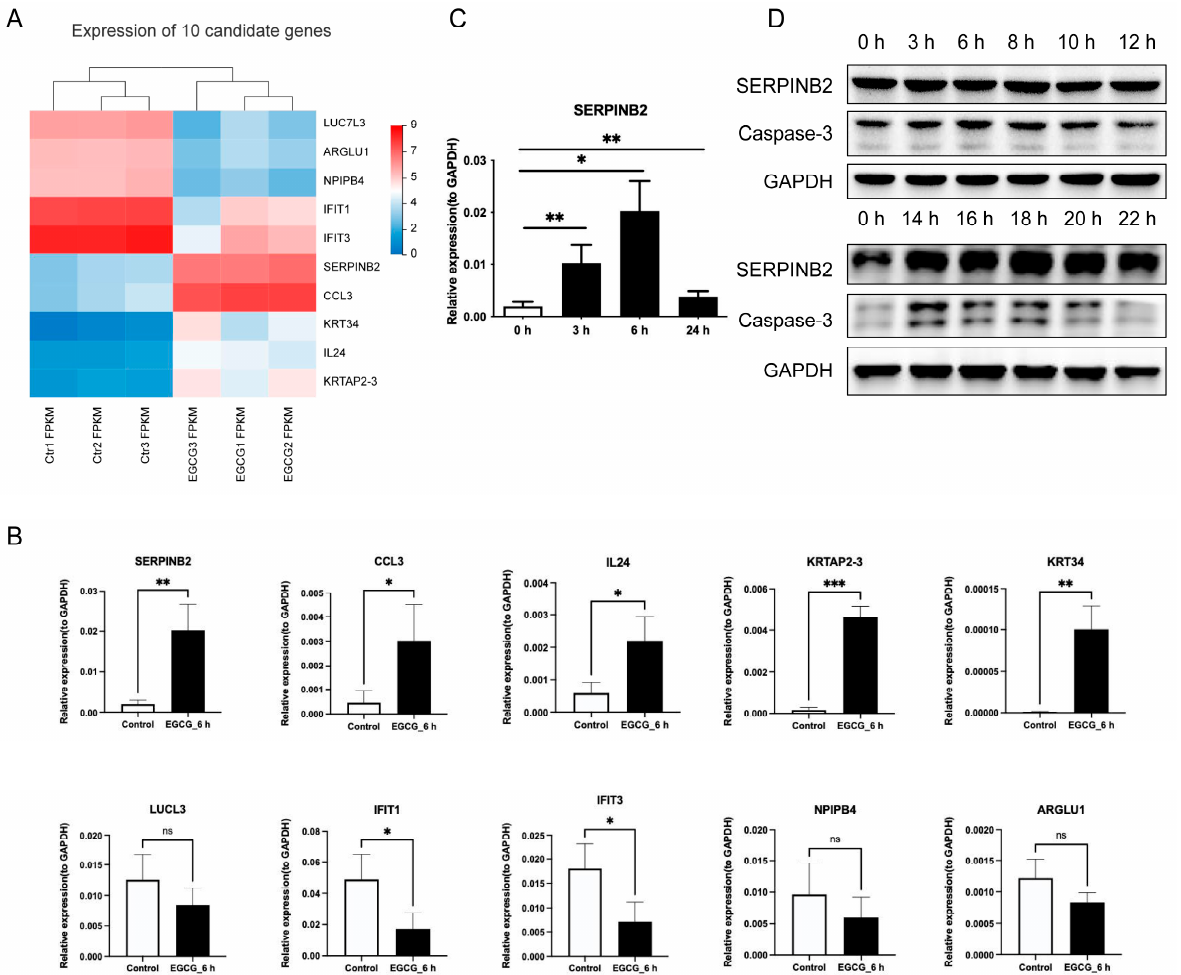
Figure 3. Validation of DEGs in KYSE150 cells. ( A ) Heatmap showing the expression levels of the top 10 up-regulated and down-regulated genes in RNA-seq. ( B ) Verification of DEGs after EGCG treatment for 6 h in KYSE150 cells. ( C ) Relative expression of SERPINB2 after EGCG treatment at 0, 3, 6, and 24 h in KYSE150 cells. ( D ) Changes of SERPINB2 and Caspase-3 protein levels at different time points in KYSE150. Data are shown as mean ± SD. n = 3, *: p < 0.05; **: p < 0.01; ***: p < 0.001, ns: not significant.